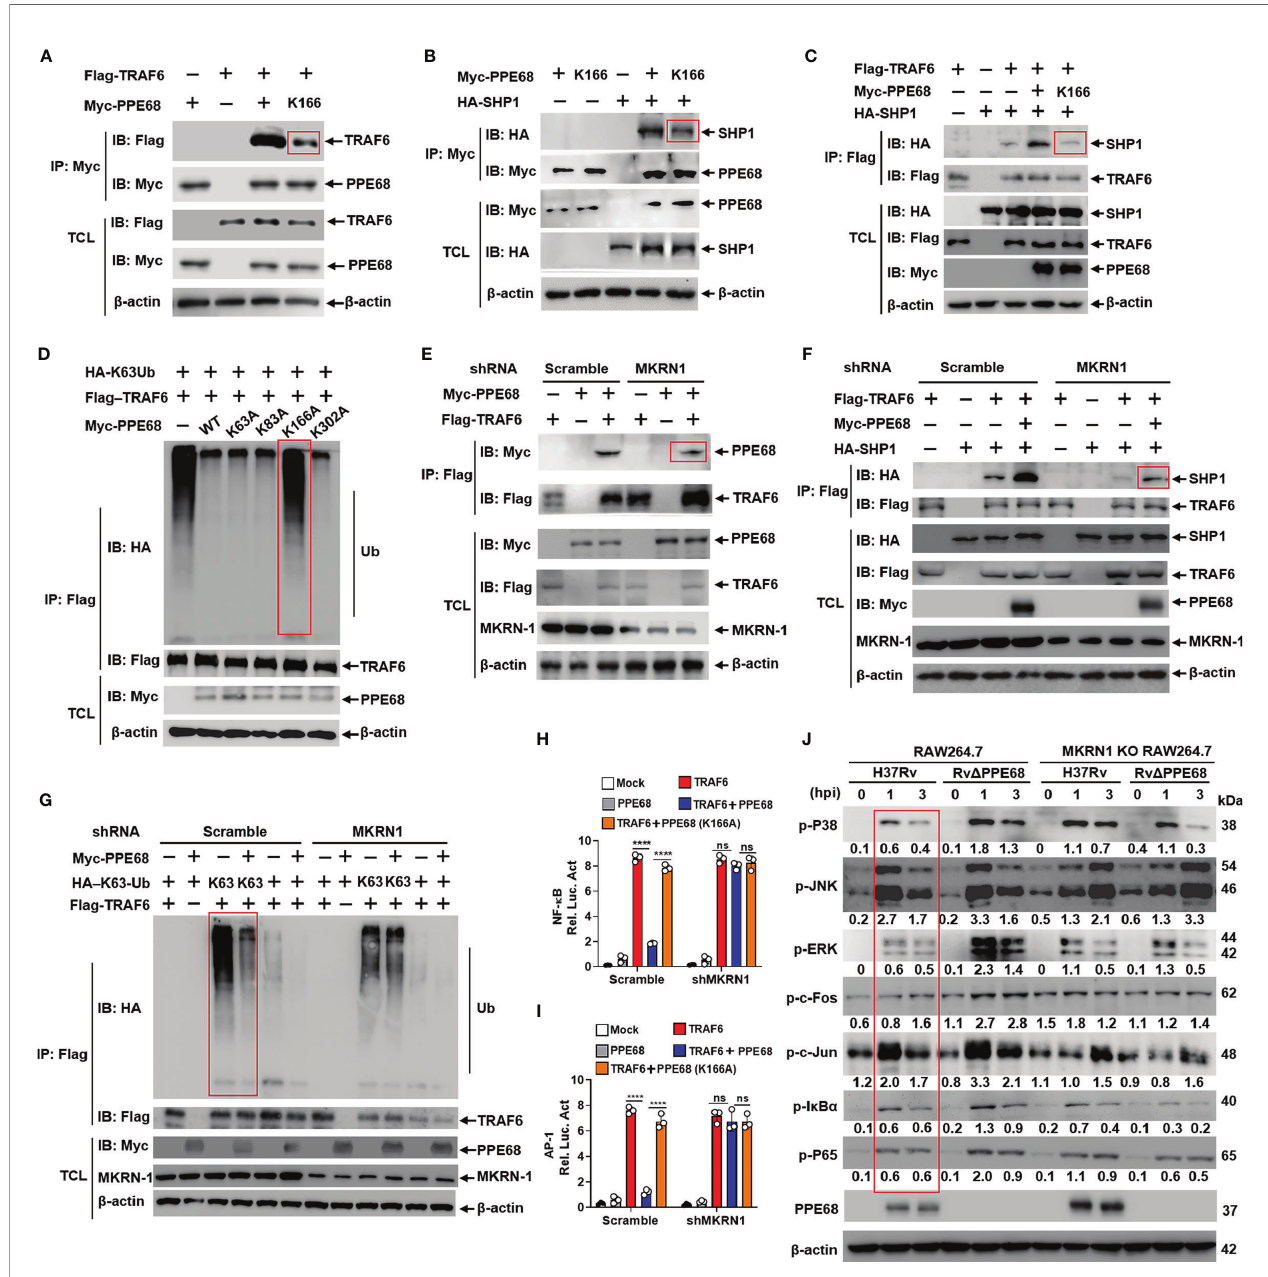
FIGURE 4 | PPE68 K166 ubiquitination interacts with TRAF6 and SHP1, and then inhibits TRAF6-NF- k B/AP-1 signaling. (A-G) HEK293T cells were transfected with the indicated plasmids for 24 h, and then cell lysates were analyzed by IP and Western blot with anti-HA, anti-Myc and anti-Flag antibodies. PPE68, but not PPE68 K166 mutant, could interact with TRAF6 (A) and SHP1 (B) . PPE68, but not PPE68 K166 mutant, overexpression could promote the interaction between TRAF6 and SHP1 (C) , and TRAF6 ubiquitination (D) . PPE68 interaction with TRAF6 was reduced after MKRN1 silencing (E) . After MKRN1 silencing, PPE68 overexpression could not promote the interaction between TRAF6 and SHP1 (F) , and could not inhibit TRAF6 K63 ubiquitination, either (G) . (H, I) After MKRN1 silencing, PPE68, but not PPE68 K166 mutant, could not inhibit TRAF6-driven NF- k B (H) and AP-1 (I) activation. Dual luciferase reporter assay of the effects of PPE68 or PPE68(K166A) and TRAF6 on the NF- k B (H) or AP-1 (I) activation in HEK293T cells co-transfected with shMKRN1 and Scramble for 24 (h) (J) H37Rv PPE68 inhibits NF- k B/MAPK signaling molecules phosphorylation dependent on MKRN1. Western blot analysis of phosphorylated P38, JNK, ERK, c-Fos, c-Jun, P65, I k B a and P65 and total b -actin (loading control throughout) in WT and MKRN1 KO RAW264.7 cells infected with H37Rv or Rv D PPE68 for the indicated time. Densitometry quanti fi cation as shown in panel (J) was analyzed based on b -actin by ImageJ. TCL, total cell lysates. The data are expressed as the mean ± SD of three independent replicates for (H, I) Two tailed unpaired t test was used to calculate statistical signi fi cance. p > 0.05, not signi fi cant (ns); **** p <